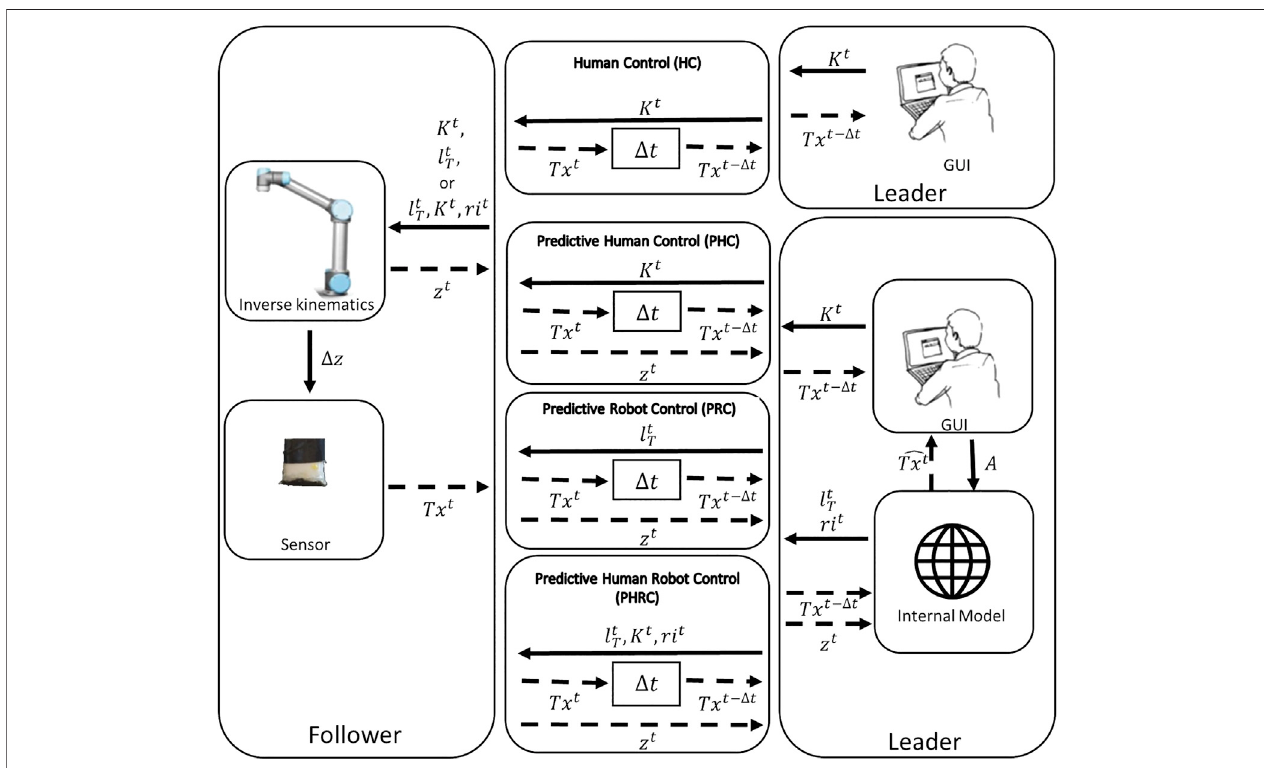
FIGURE 3 | Schematics of the control in the four different modalities: HC , PHC , PRC , PHRC , from top to bottom. In the fi gure, K represents the information about thekeyspressed bytheuser( “ up ” and “ down ” ), l T isthetargetpositionselectedbytheinternalmodel, ri istherobotinitiative, A istheanswergivenbytheuserattheend of thetask, z isthe information about the z coordinate oftheend-effector, Δ z isthemotion ofthe end-effector alongthe same direction, Tx isthesensor ’ sdata about the taxels, and ^ Tx is the predicted sensor ’ s data obtained from the internal model. The apex t is used for any not delayed signal whereas Δ t is the introduced delay.